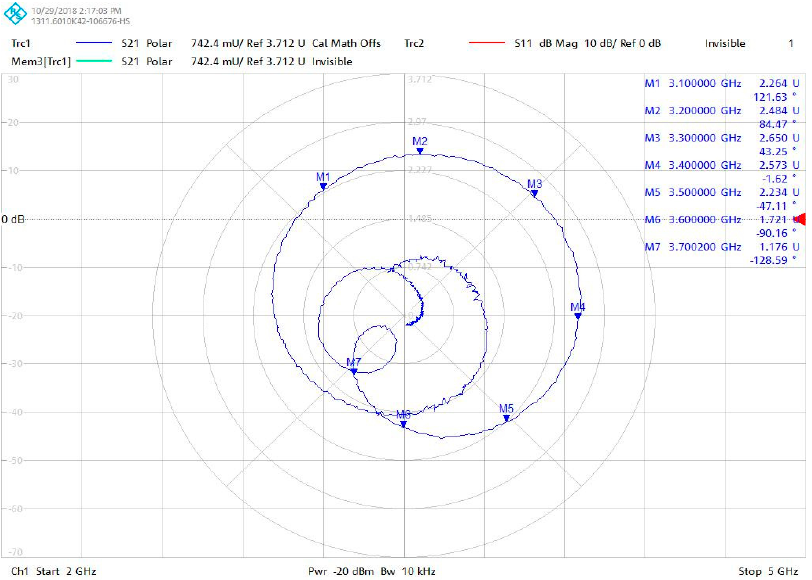
Figure 10. The measured gain phase of the Doherty power amplifier when only the carrier amplifier is working.